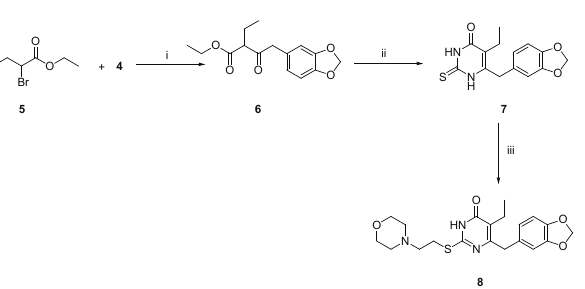
Figure 2: Linear curve fitting plots of the calculated and experimental bond lengths and bond angles parameters for the title compound. Table 1: The calculated optimized geometrical parameters of compound at B3LYP/6- 311++G(d,p) level of basis set. Figure 1: The optimized molecular structure of the title molecule based on the B3LYP/6- 311++G(d,p) level of basis set.